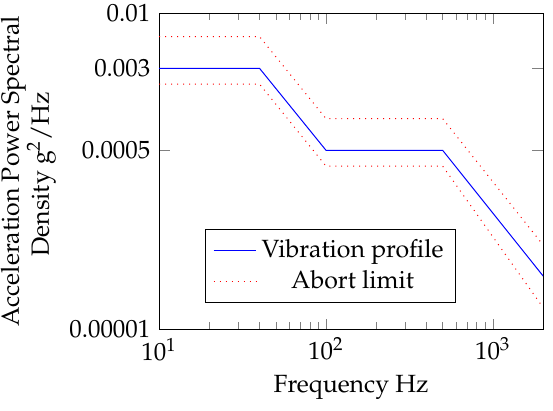
Figure 4. Random vibration profile, APSDprofile slopes − 6